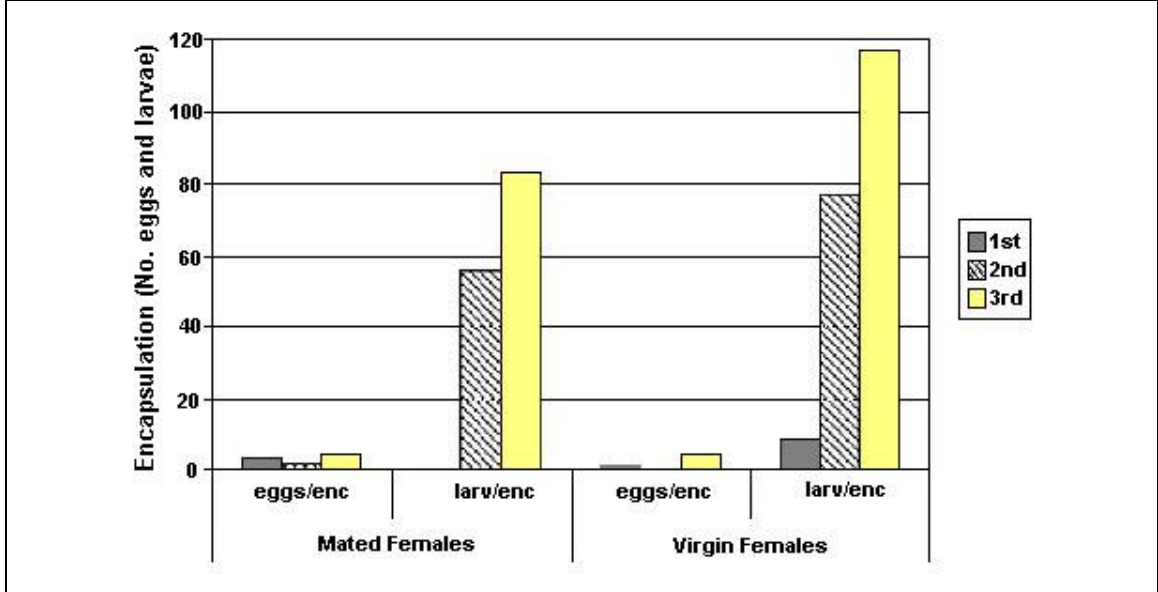
Figure 3: Number of eggs (egg/enc) and larvae (larv/enc) encapsulated by 4 th instar Diatraea saccharalis caterpillars parasitized by mated and virgin Cotesia flavipes females in the 1 st , 2 nd and 3 rd